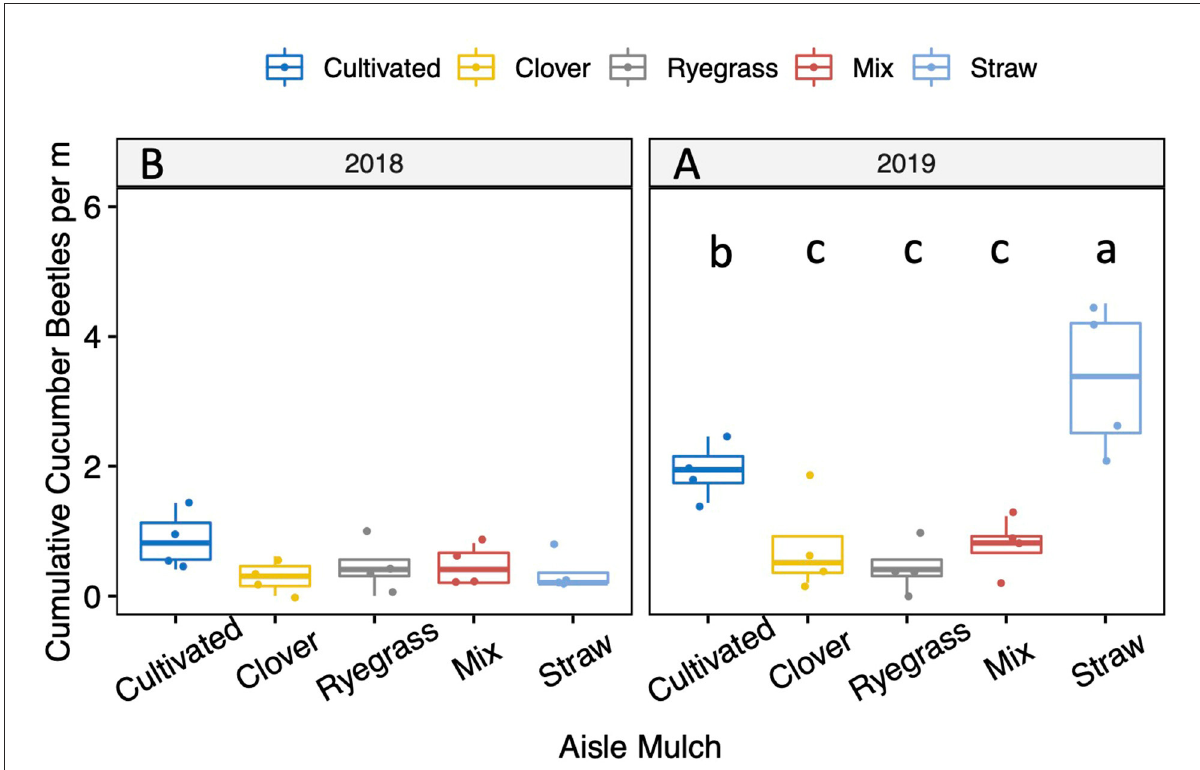
FIGURE2 Cumulative cucumber beetles m − 1 on organic zucchini plants grown using cover crop living mulches, averaged across 2018 and 2019. Treatments with the same lowercase letter (or no letter) were not significantly different within the same year at p < 0.05, while uppercase letters indicate groupings for year across mulch